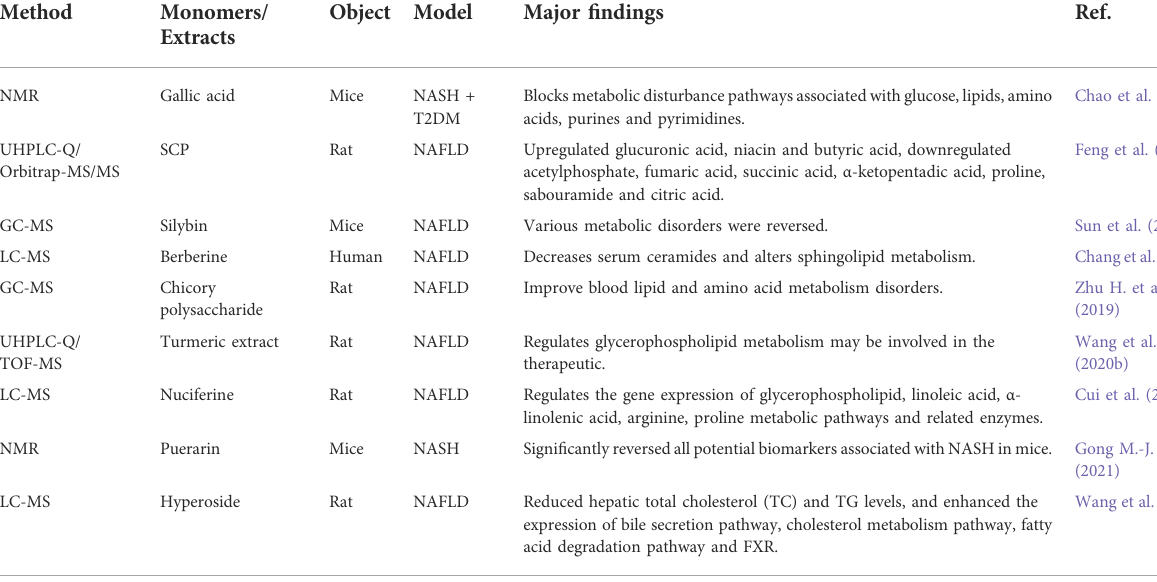
TABLE 1 The therapeutic effect of Chinese medicine extract on NAFLD.